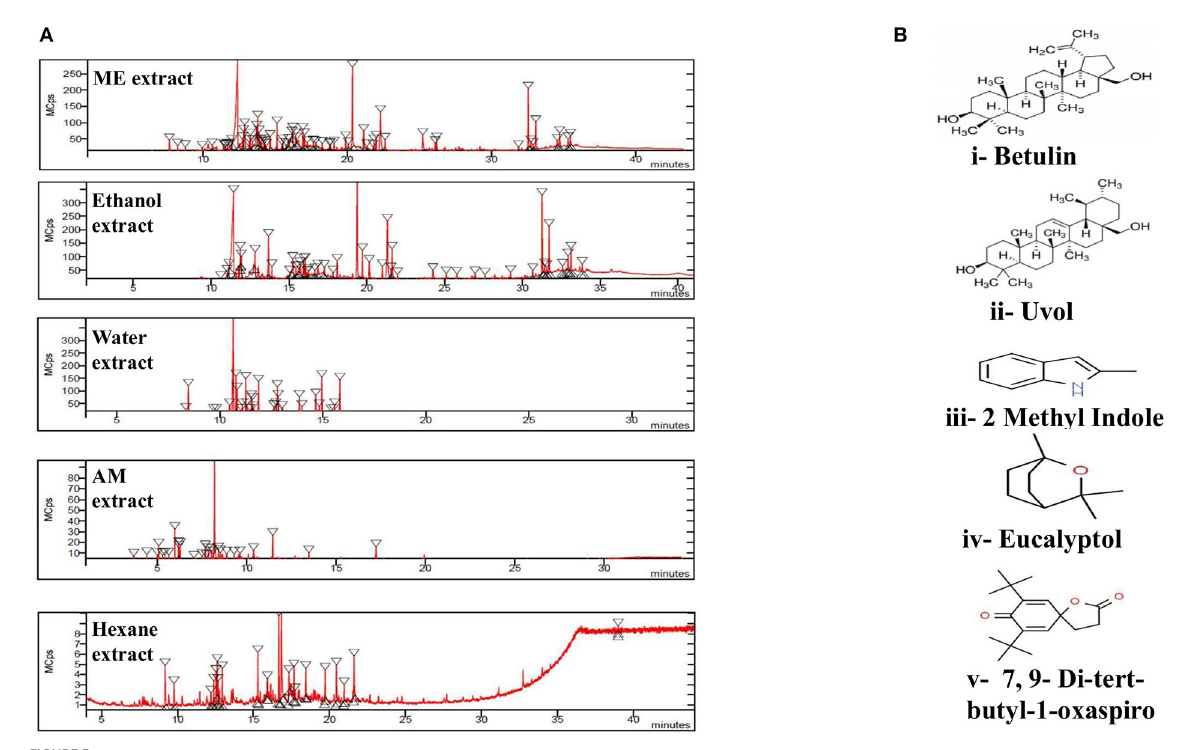
FIGURE5 (A) GC/MS chromatogram of set of extracts of Nepeta cataria showing peaks of metabolites in each extract. (B) The 2-D structures of important phytochemicals are retrieved via PubChem. i. Betulin was most abundant phytochemical in methanol and ethanol (ME), ii. Uvol in ethanol, iii. 2-methyl Indole in water, iv. Eucalyptol in acetone and methanol (AM) and v. 7,9-Di-ter-butyl-1-oxaspiro is most abundant phytochemical in hexane extract.